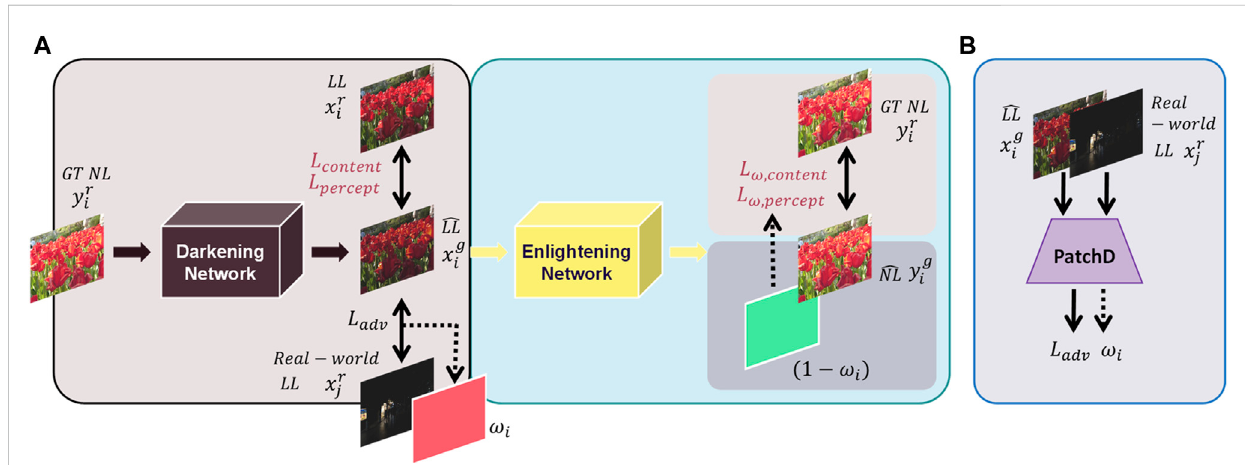
FIGURE 2 (A) The proposed Domain-Gap Aware Framework contains two stages, i.e., the Darkening stage and Enlightening stage. (B) Adversarial training during the training of Darkening